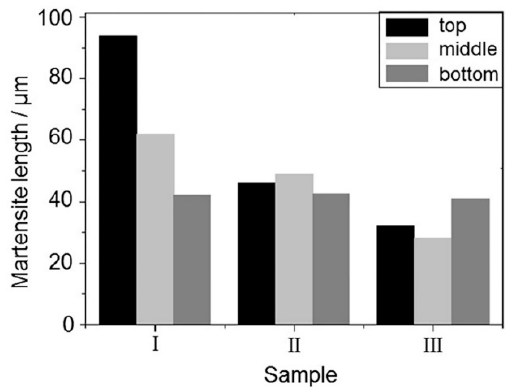
Figure 6. The comparison of longitudinal acicular martensite length.